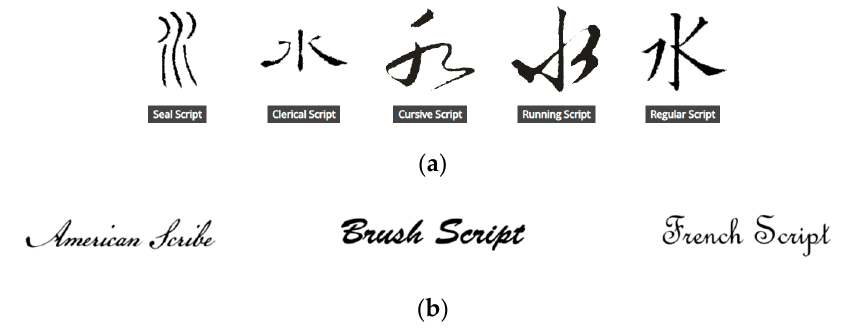
Figure 1. Calligraphy styles and script typefaces. ( a ) Five basic styles in oriental calligraphy (from left to right): seal script, clerical script, cursive script, running script, and regular script [2]. ( b ) Some script typefaces of western languages [5].